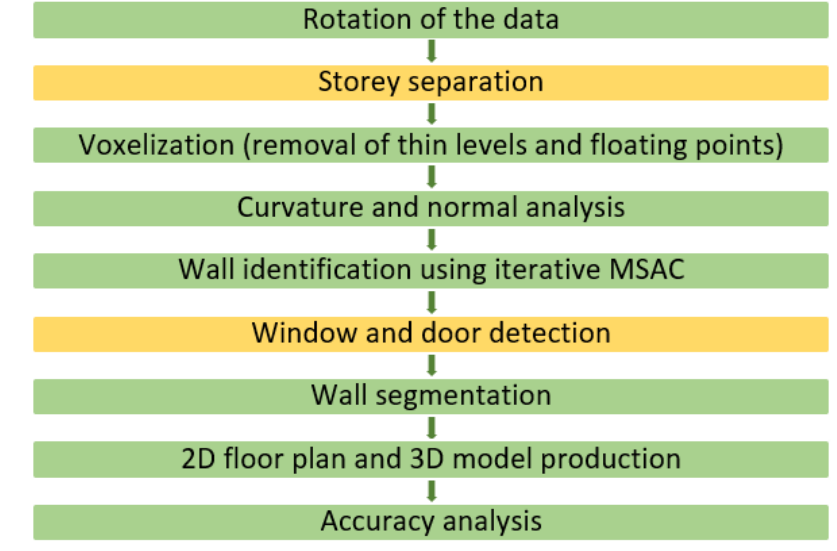
Figure 1. Flowchart of methodology, novel methodologies in yellow.